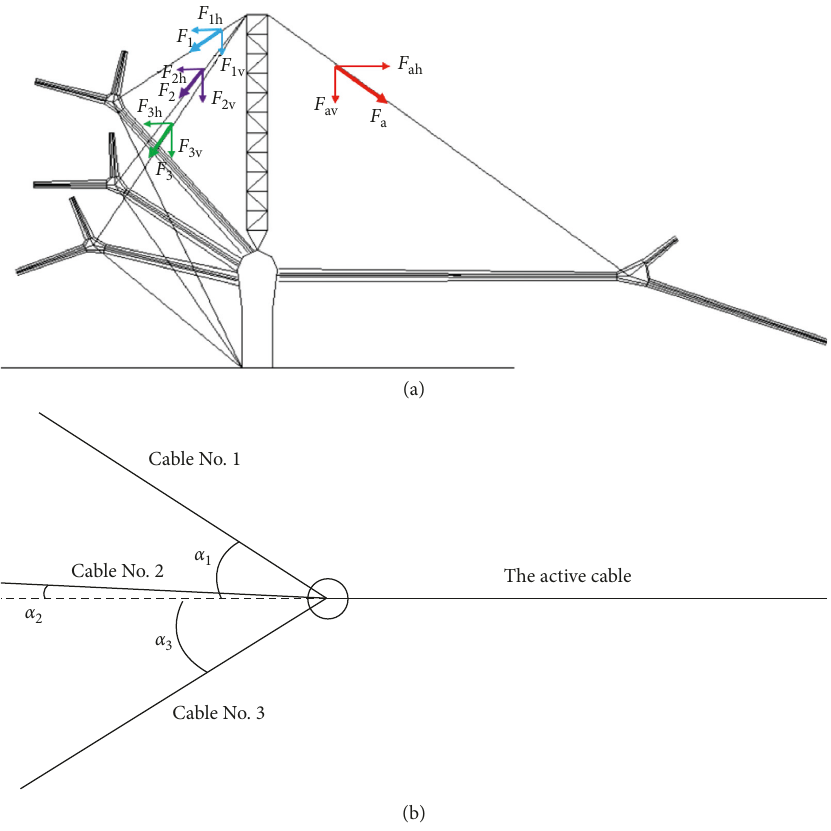
Figure 5: Force diagram of cable. (a) Diagram of cable force. (b) Plane projection diagram of